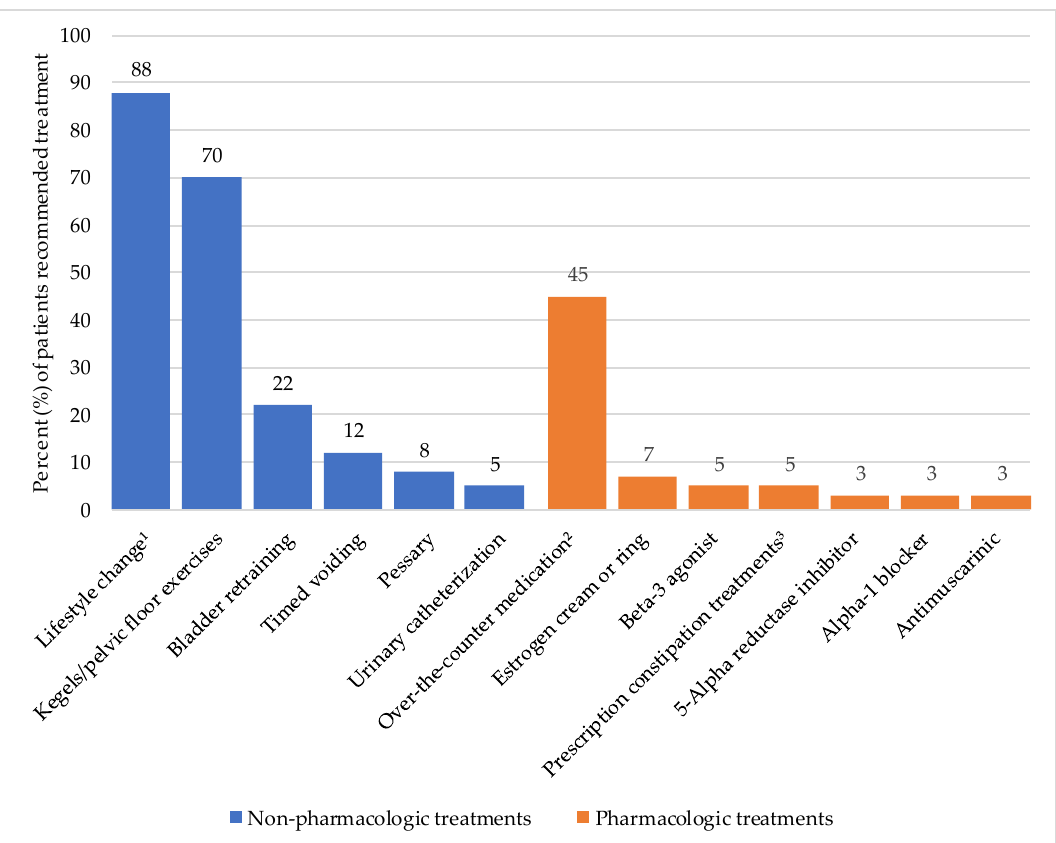
Figure 2. Treatments for incontinence. 1 Fluid restriction, increasing water intake, avoiding bladder irritants, dietary modification, increasing fibre intake, exercise and weight loss, personal hygiene education, stress/anxiety reduction techniques. 2 Barrier cream, psyllium fibre tablets, polyethylene glycol 3350, senna, bisacodyl, perineal lotion, and non-hormonal moisturizing gel. 3 Lactulose, cholestyramine.